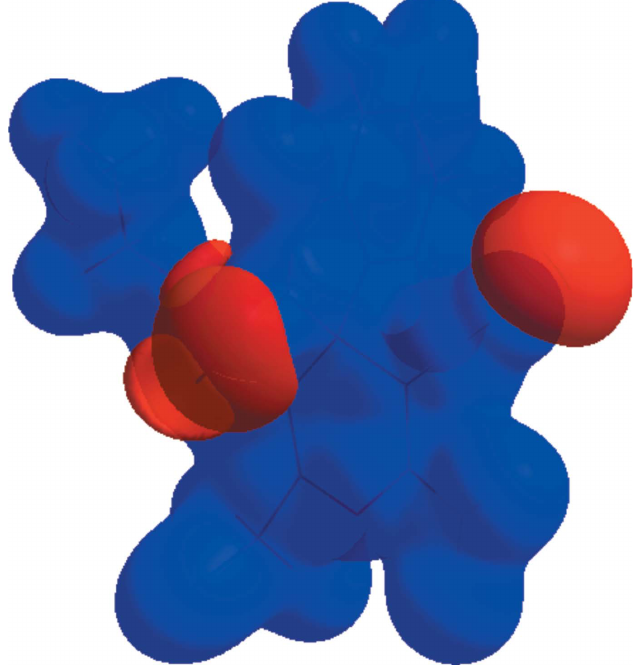
Figure 6 View of the three-dimensional Hirshfeld surface of the title compound plotted over electrostatic potential energy in the range (cid:4) 0.0500 to 0.0500 a.u. using the STO-3 G basis set at the Hartree–Fock level of theory. Hydrogen-bond donors and acceptors are shown as blue and red regions around the atoms, corresponding to positive and negative potentials,